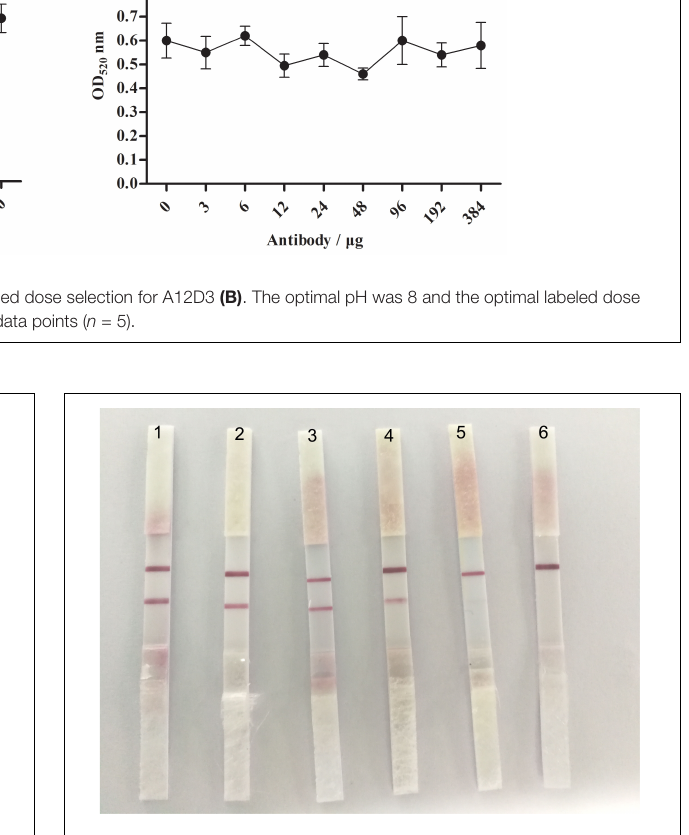
FIGURE 5 | The sensibility of the ICS. The dilution multiples were prepared as follows; 1: 1/10, 2: 1/50, 3: 1/100, 4: 1/200, 5: 1/500, and 6: PBS. A fainter test line appeared at